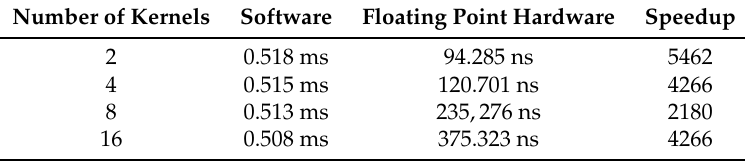
Table 2. Execution time, t s , of the XOR gate dataset—floating point.